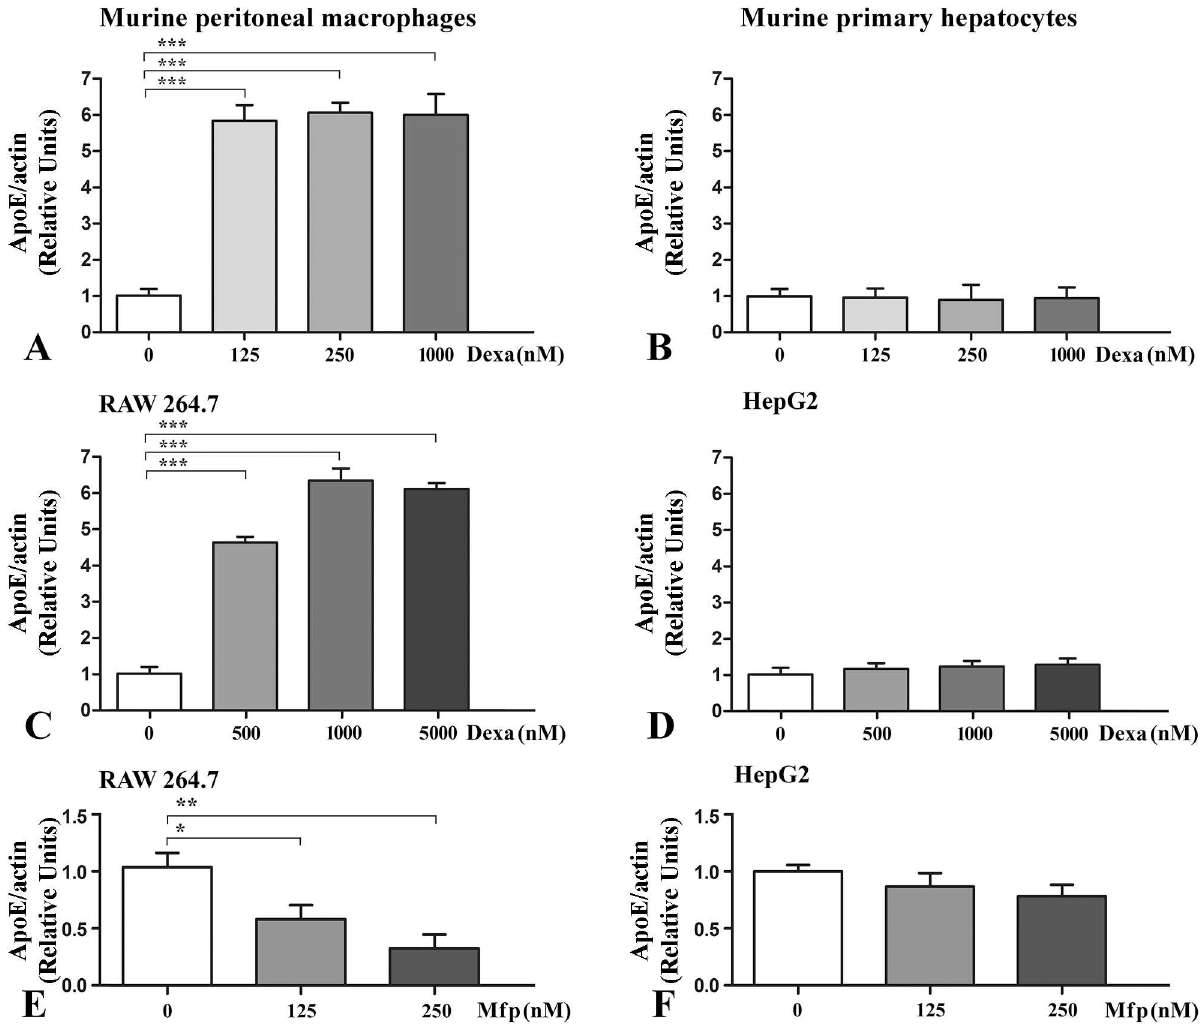
Fig 1. In vitro cell-specific modulation of apoE gene expressionin response to glucocorticoid receptor agonist and antagonist in cultured macrophages and hepatocytes. ApoE geneexpression in freshly isolatedmouseperitoneal macrophages(A), murineprimary hepatocytes(B) and established cell lines,RAW 264.7(C, E) and HepG2 (D, F) exposedfor 24 hoursto increasingconcentrationsof dexamethasone(GR ligand)or mifepristone(GR antagonist) was assessed by Real-Time PCR. Dexamethasoneincreasesup to ~6 fold apoE mRNA levelsin mouseperitonealmacrophages (A) and RAW 264.7macrophages(C) whereasapoEgeneexpression is not significantly affected by dexamethasonein murineprimaryhepatocytes (B) and HepG2 hepatocytes(D). Mifepristone treatmentsignificantlydecreases apoEmRNA levelsin RAW 264.7macrophages (E) but not in HepG2hepatocytes(F). The symbolsare: *** p < 0.001, ** p < 0.01and * p < 0.05.